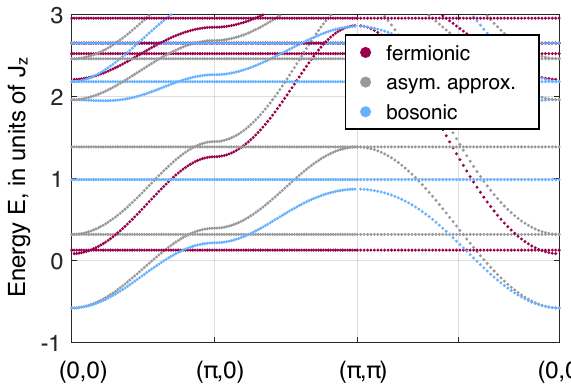
= 1. We used a maximum z